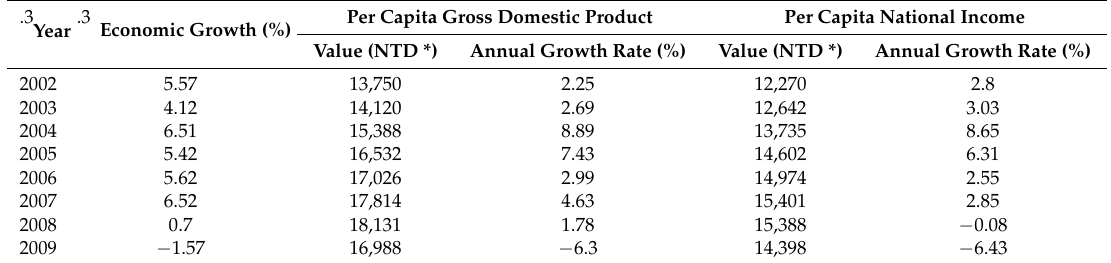
Table 2. The economic growth and gross domestic product in Taiwan, 2002–2009.